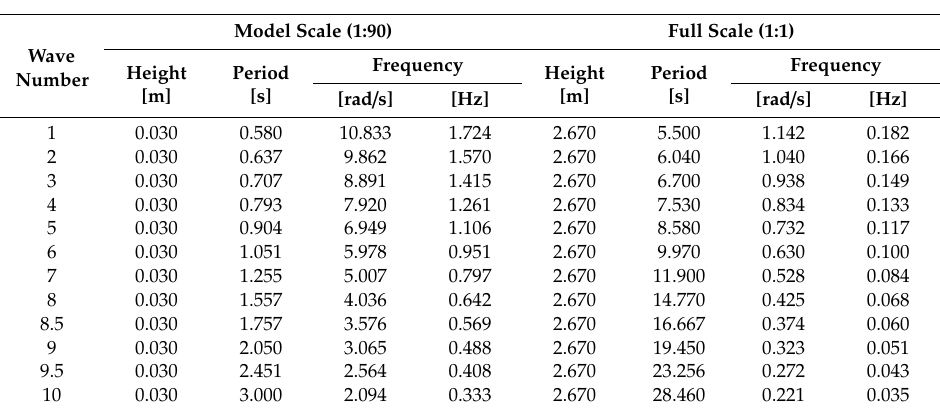
Table 7. Regular waves for model